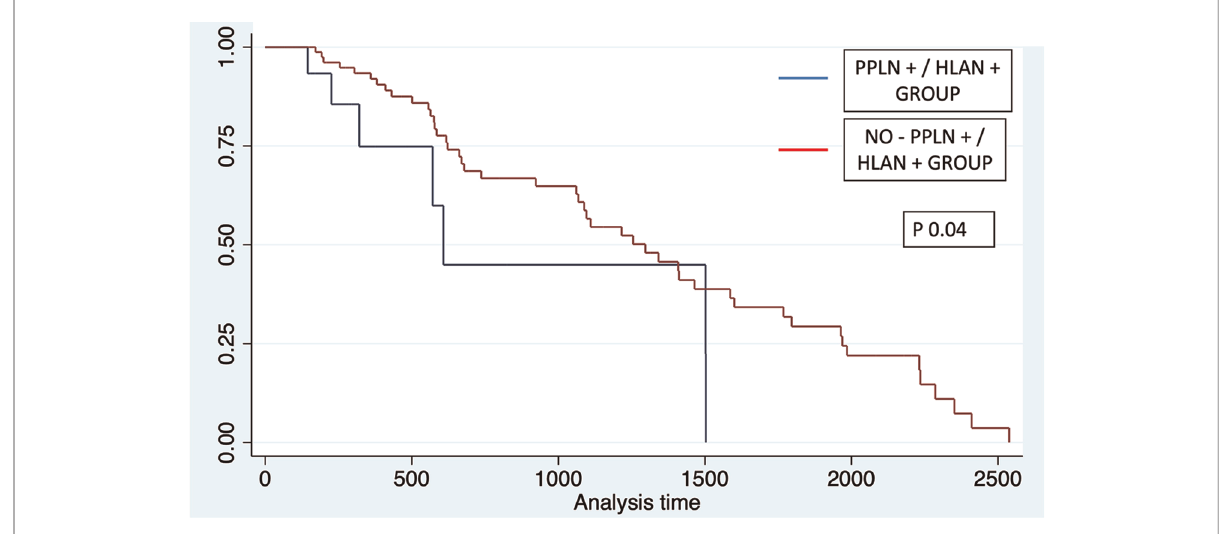
FIGURE 4 KAPLAN – MEIER curve estimates for OS and lymph node subgroup analysis.